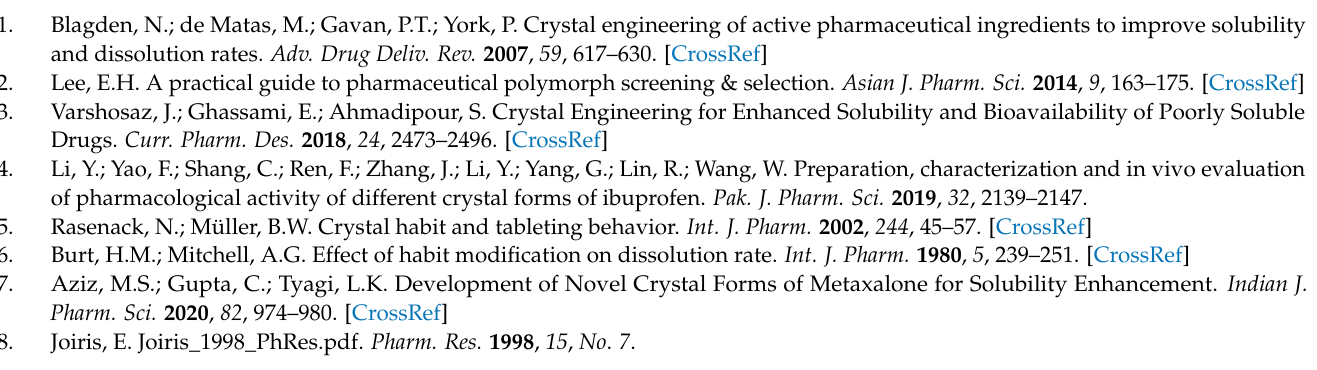
(b), APT-EA long tabular crystal habit (c). Figure S2: FTIR graph of tabular crystal habit. Figure S3: FTIR graph of long tabular crystal habit. Figure S4: FTIR graph of irregular plate crystal habit. Figure S5: Simulated PXRD of APT form I (CCDC number